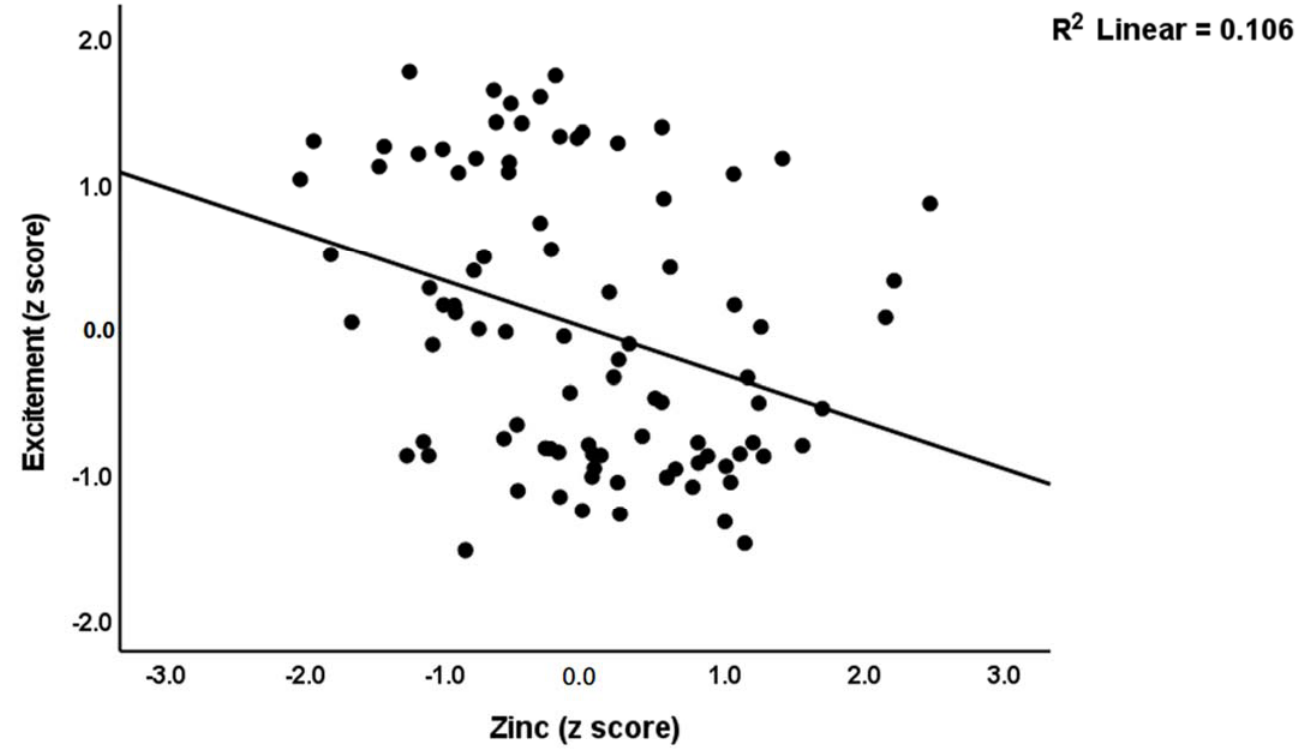
Figure 2. Partial regression plot of excitement on serum zinc levels.